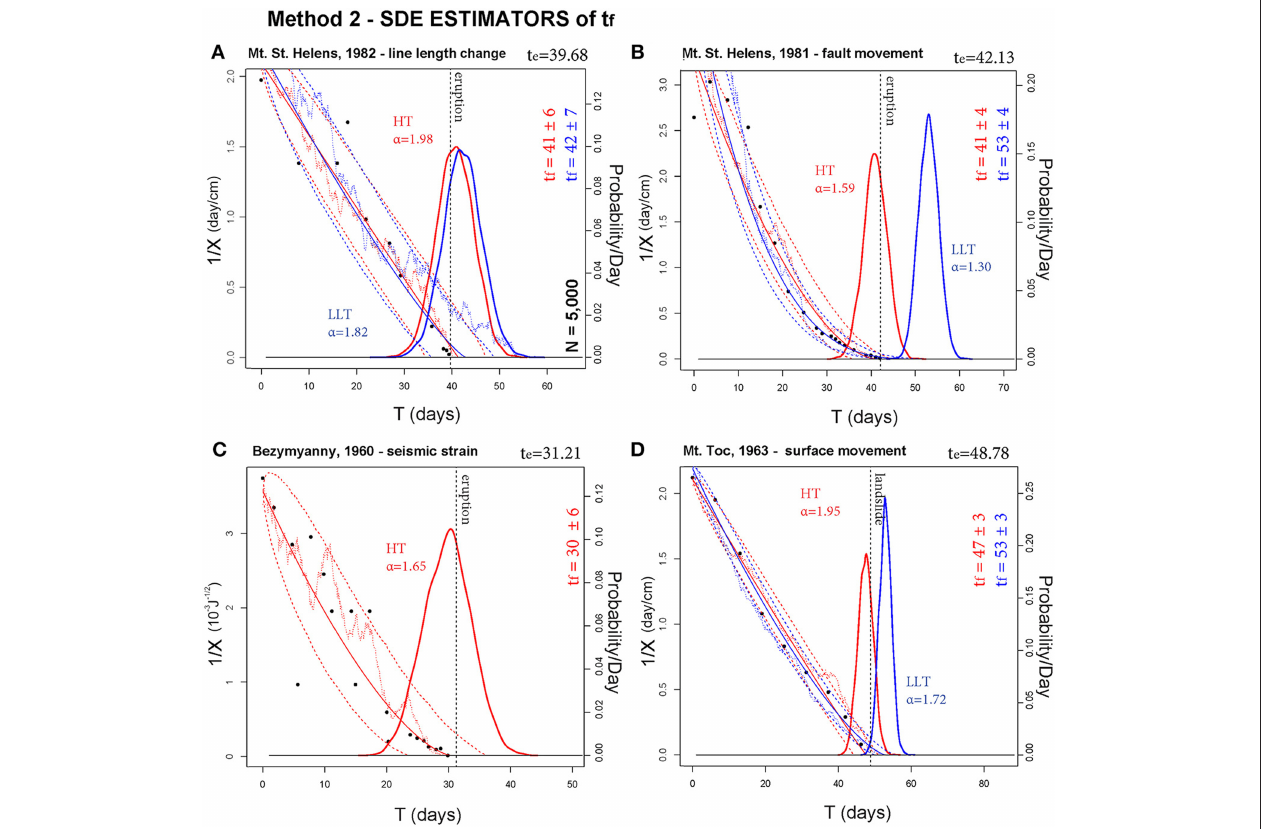
FIGURE 5 | Estimators of t f based on Method 2. In (A–D) are reported four different case studies. Blue lines assume α as from LLT, red as from HT. A bold line is g t The probability/day scale bar is related to g t . Thin dashed lines bound the 90 % confidence interval of the SDE paths of 1 / X , and a thin continuous line is the mean f path. Black points are inverse rate data. Thin dotted lines show examples of random paths. A dashed black line marks t e . Method 2 reduces the overestimation issues of LLT observed in Method 1 (see Figure 5 ), but model uncertainty is